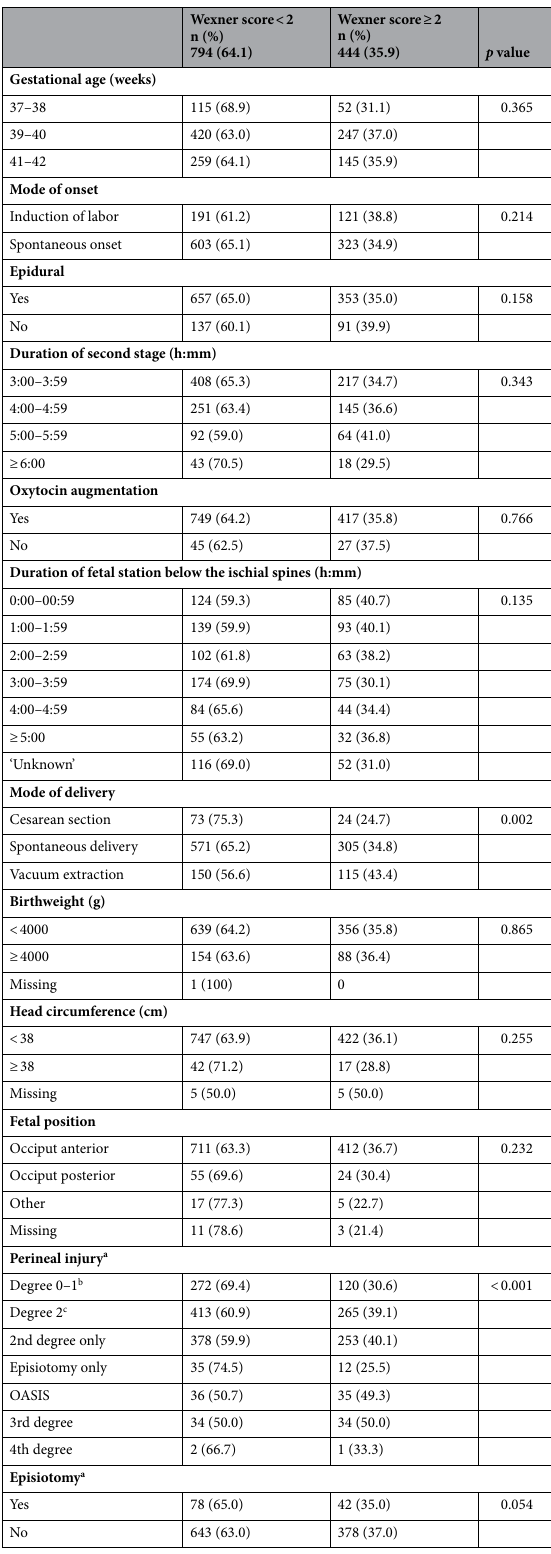
Table 2. Delivery characteristics and outcomes in women with Wexner score < 2 and ≥ 2. 64 women (4.9%) had missing data on Wexner score. a Vaginal deliveries only, Wexner score < 2 n = 721 Wexner score ≥ 2 n = 420. b No diagnosis, 1st degree or isolated vaginal tear. c 2nd degree including episiotomy. Missing values presented when prevalent. P values are calculated using Chi 2 tests excluding missing